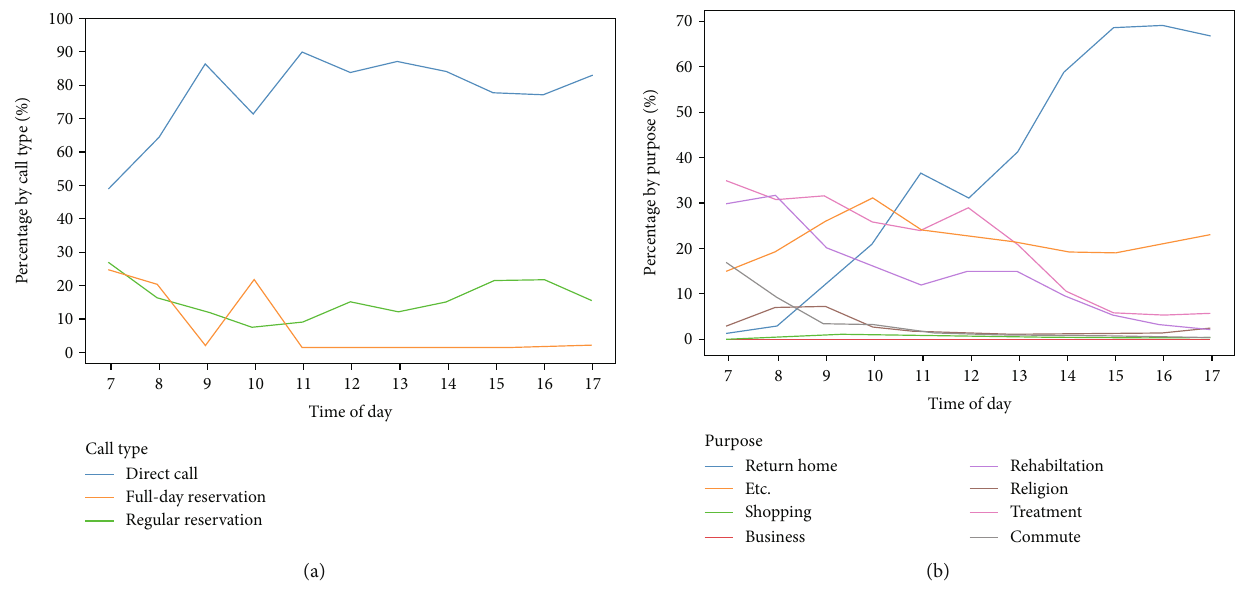
Figure 8: Percentage of demand for di ff erent (a) purposes of use and (b) call types based on hours. Table 2: Comparison of various